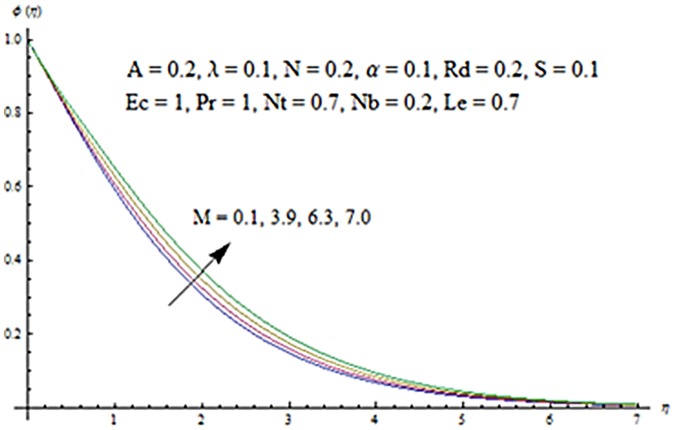
Influence of M on ϕ.